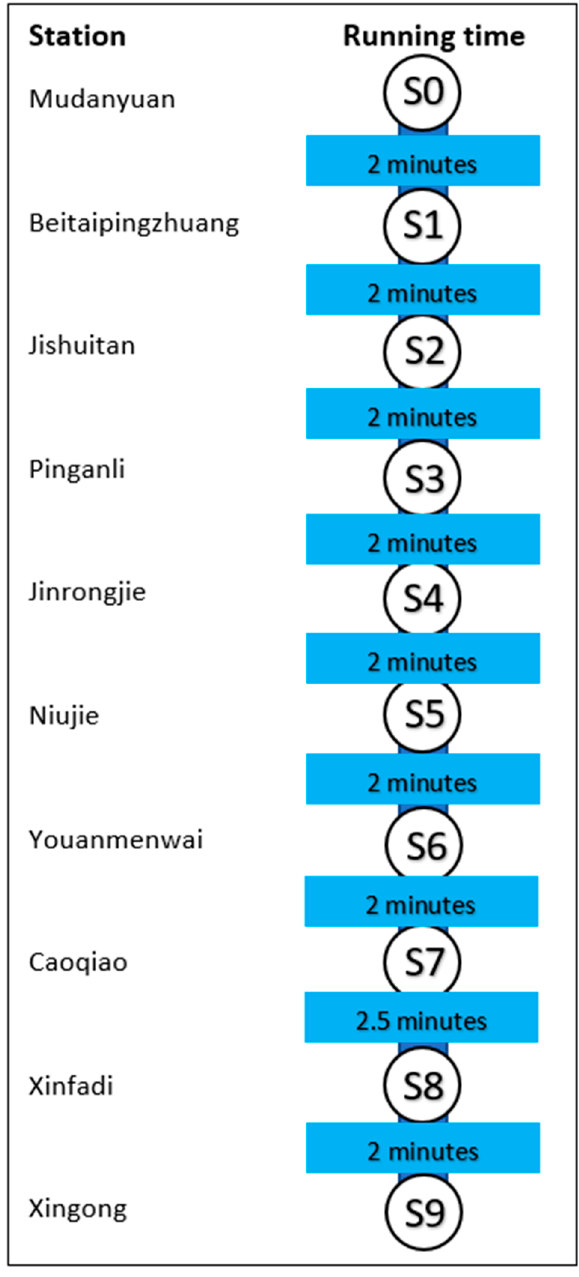
Figure 6. Simplified line information and the running time of Beijing Metro Line 19.